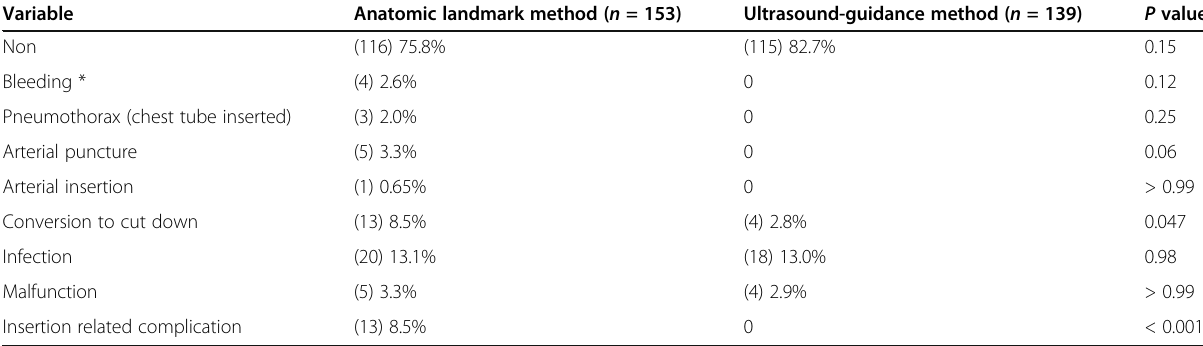
Table 3 Procedure complications.